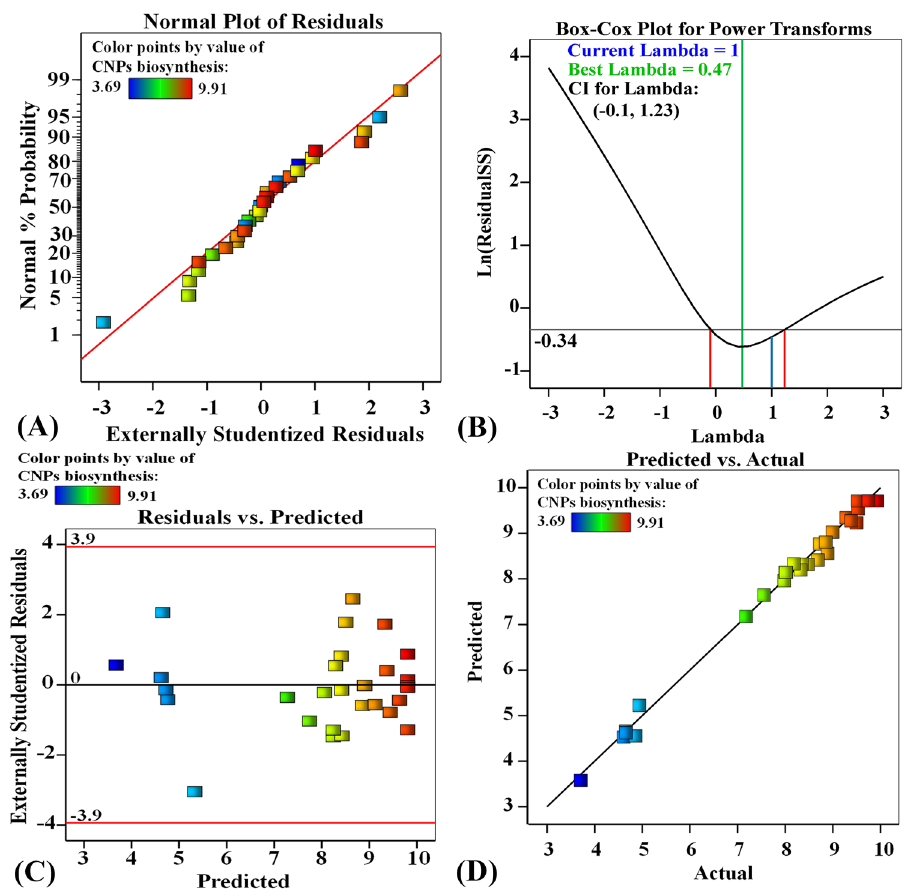
Figure 3. ( A ) Normal probability plot of internally studentized residuals, ( B ) Box–Cox plot of model transformation, ( C ) plot of predicted versus residuals, and ( D ) plot of internally studentized actual values versus predicted values of for chitosan nanoparticles biosynthesis using Eucalyptus globulus Labill leaves